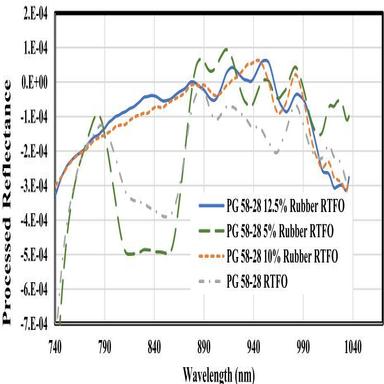
Comparison of the PG 58-28 RTFO binders with different rubber content.